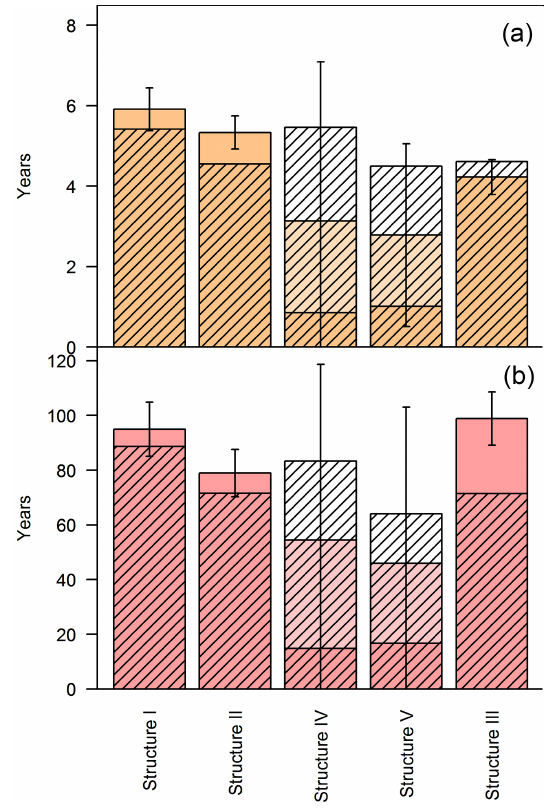
Figure 3. MRT of the young pool (a) and old pool (b) of SOC in the ZOFE trial as indicated by the model structures examined, with weighting factor = 0.35 (solid colored area) and weighting fac- tor = 0.65 (shaded area). The solid lighter colored area denotes the , while MRT calculated (for structures IV and V) according to 1 k × α the darker colored area according to 1 , Error bars, reported only for k weighting factor = 0.35 for readability reasons, denote the error of the estimate calculated as standard deviation of the whole Markov chain and depends on the model structure, model assumptions, and